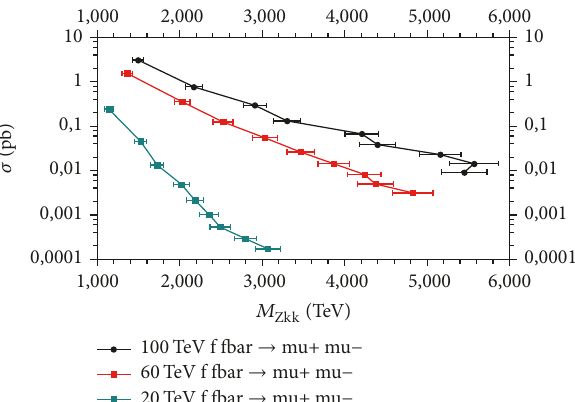
Figure 4: Production cross sections at 20 TeV, 60 TeV, and 100TeV at the center of mass energies as a function of KK mass for TeV −1